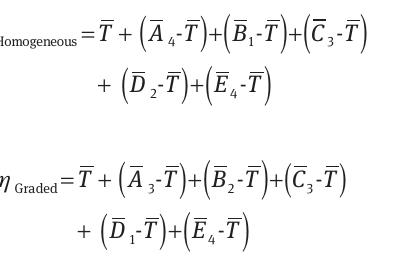
Table 5 Results of the confirmation experiments for wear rate of CBPD reinforced FGMs and homogeneous